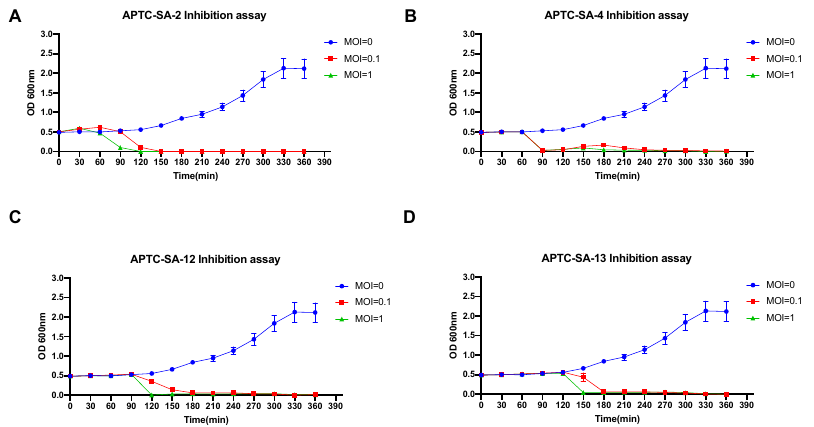
Figure 3. Inhibition assays of S. aureus phages. S. aureus ATCC25925 log-phase culture was infected with phages APTC-SA-2 ( A ), APTC-SA-4 ( B ), APTC-SA-12 ( C ), and APTC-SA-13 ( D ) at MOI = 0 (blue), 0.1 (red), and 1 (green). OD 600 nm was measured at time point = 0 and every 30 min up to time point 390 min. The error bars indicate SD from the results of three independent experiments.